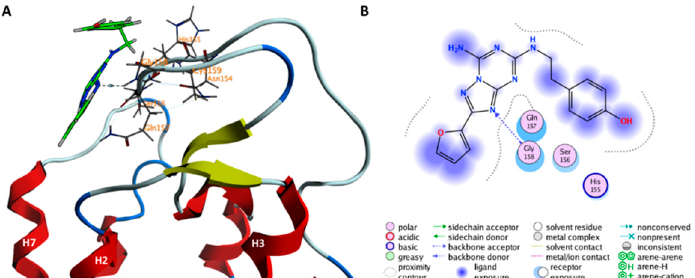
Figure 6. ZMA binding poses in the minimum F of Figure 1 are shown in the ( A , B ) panels, as 3D and 2D representation, respectively. In ( A ) the protein backbone is render as cartoon, ZMA is shown as a green licorice, residues interacting with ZMA are shown as gray lines. Hydrogen, oxygen, and nitrogen atoms are specifically colored in white, red, and light blue, respectively.